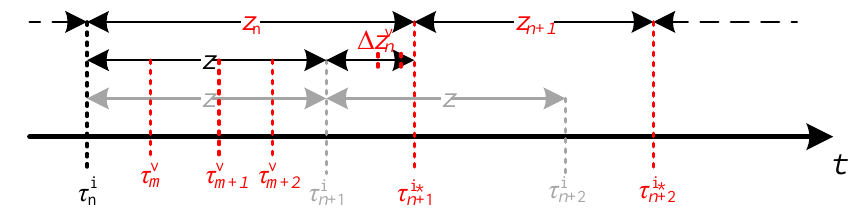
Figure 5. Dynamic inspection process considering the substation